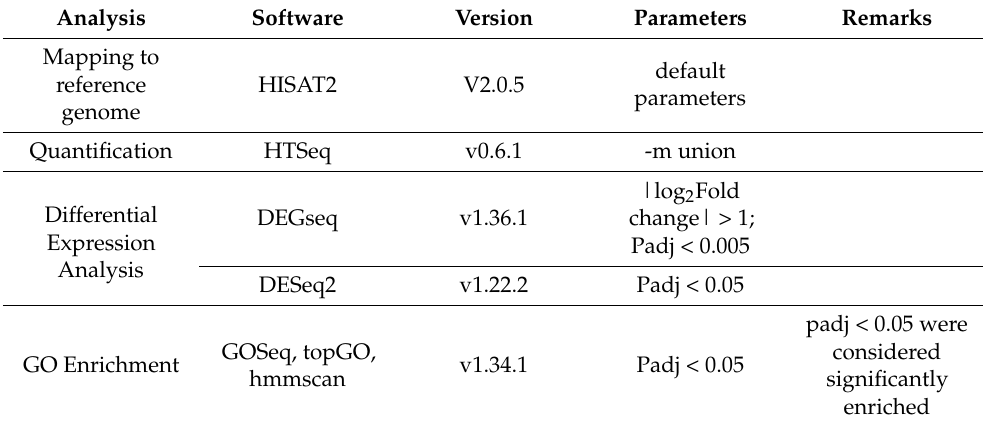
Table A8. List of software used for RNA-seq data